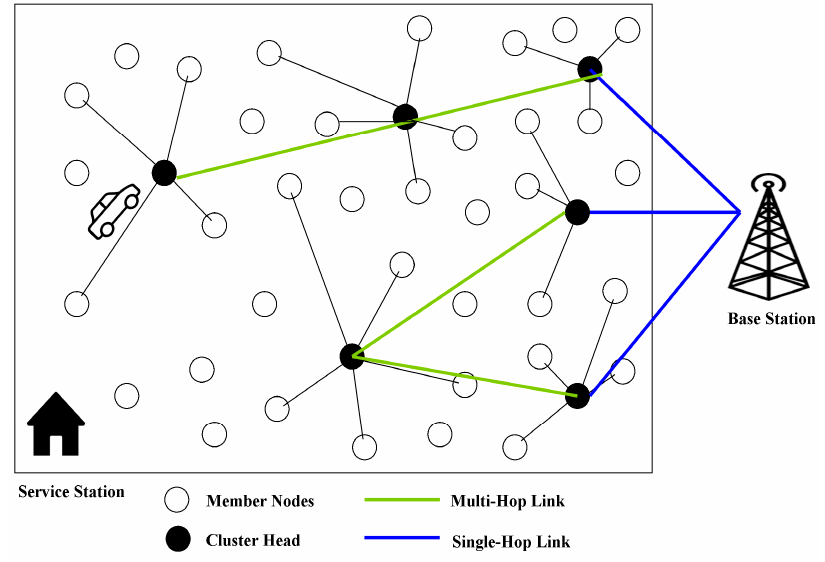
Figure 1. A WRSN with a wireless charging vehicle deployed over single-hop and multi-hop link.